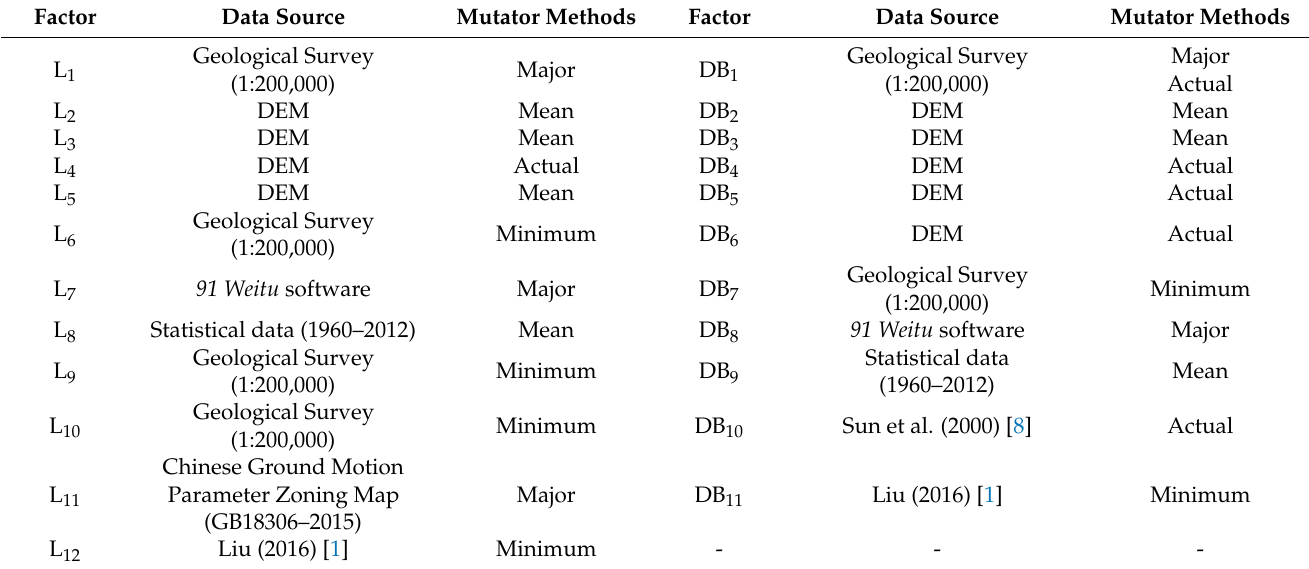
Table 2. Data sources and the mutator methods of each conditioning